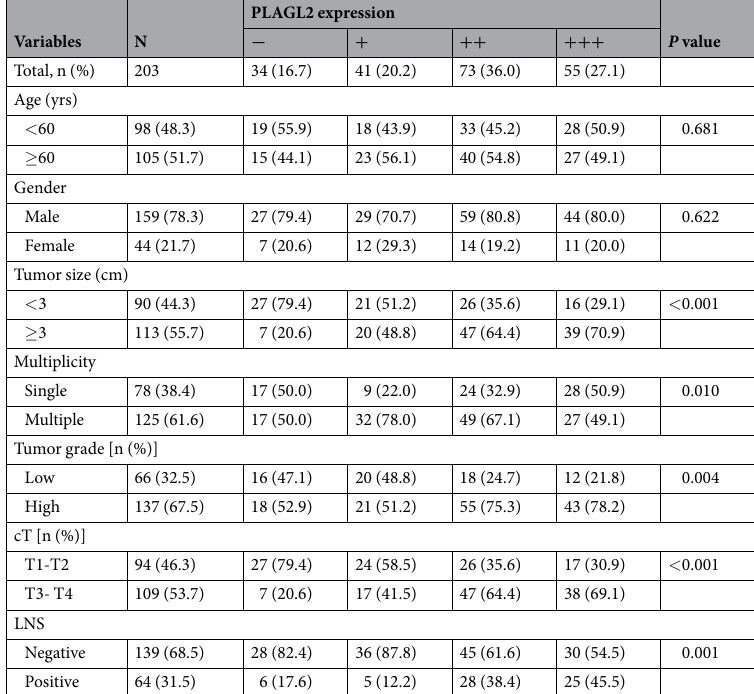
Table 3. Relationship between PLAGL2 expression and pathologic parameters in patients with BUC.